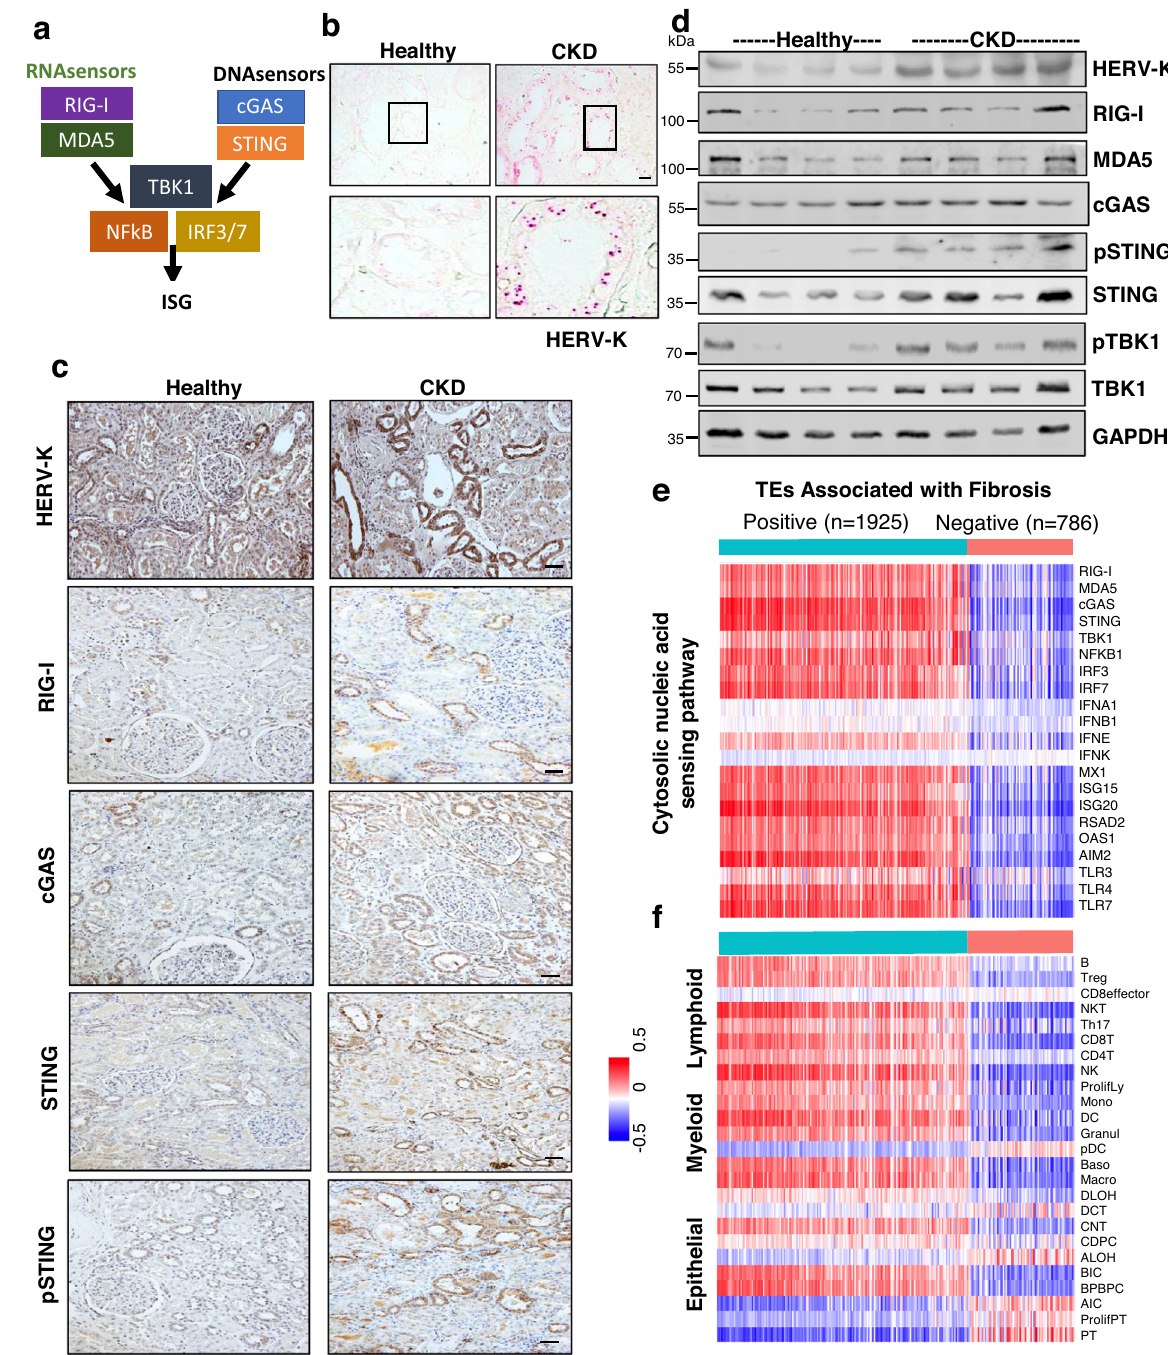
Fig. 2 | Kidney HERV expressions correlate with nucleotide sensors and immune cell fractions. a Schematic representation of cytosolic nucleic acid sen- sing pathway. b Representative images of in situ hybridization of HERV-K (pink) in healthy and chronic kidney disease (CKD) human kidneys. Scale bar, 20 μ m. c Representative immunohistochemistry images of HERV-K, RIG-I, cGAS, STING, andpSTINGproteinexpressioninhealthyandchronickidneydisease(CKD)human kidneys.Scale bar,10 μ m. d Westernblotshowing theexpressionofHERV-K,RIG-I, MDA5,cGAS,pSTING,STING,pTBK1,andTBK1proteinlevelsinhealthyandhuman chronic kidney disease (CKD) samples. GAPDH was used as a loading control. e Heatmap of correlation coef fi cients (Pearson) transposable elements (TEs) and genesinthecytosolicnucleicacidsensingpathwayinhumankidneysamples.Each column is one TE expression, and each row is one gene expression. Red indicates